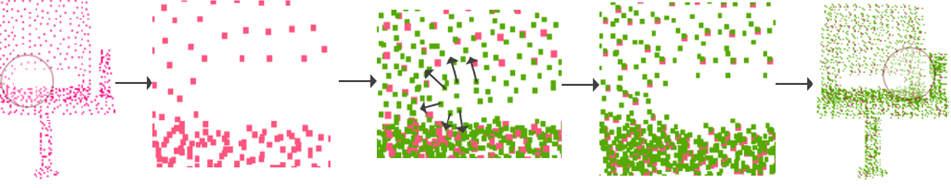
Figure 3. Retain the holes in the chair. The green upsampled point cloud covers the holes of the chair. We have to add constraints to the green point cloud so that the hole information of the chair is